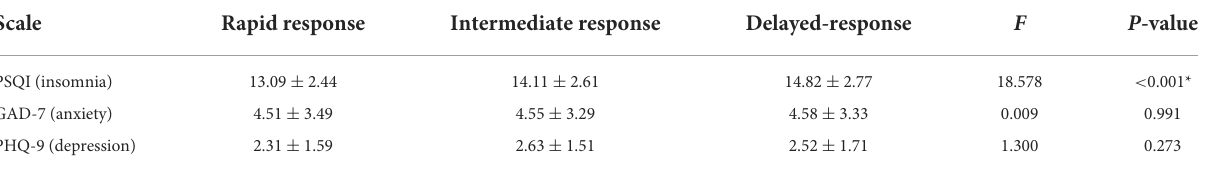
TABLE 2 Scores of the three groups at baseline [mean ± standard deviation